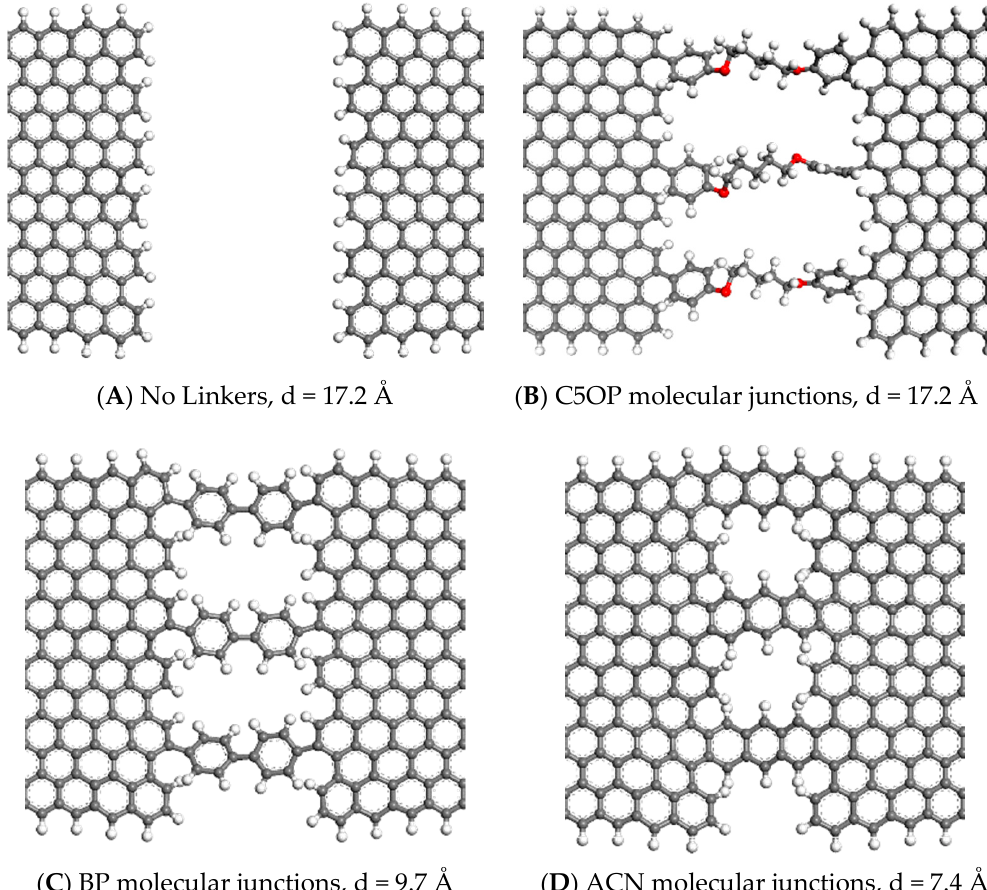
Figure 3. Detail of the molecular junctions connecting graphene sheets in polymer bound models. ( A ) is the junction without linkers (No Linkers) while three molecules constitute the junction made of ( B ) C5OP, ( C ) BP and ( D ) ACN. The letter “d” indicates the distance between the graphene edges. Color codes: carbon atoms in grey, oxygen in red, hydrogen in white.